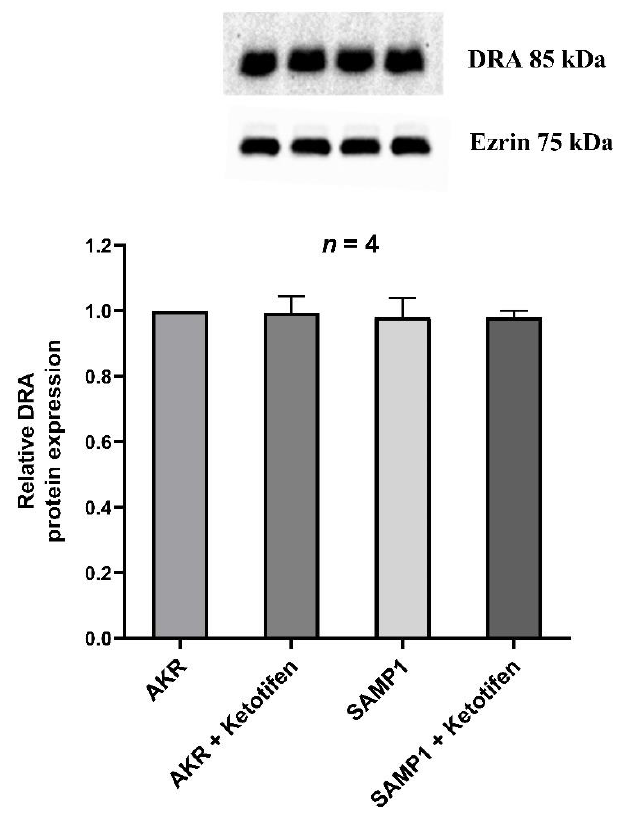
Figure 7. Effect of ketotifen on villus cell BBM DRA protein expression during chronic ileitis. Western blot analysis showed that villus cell BBM DRA protein levels remained unaltered in all experimental conditions (a representative blot in the top panel). Densitometric analysis as shown in the bottom panel confirmed these findings.